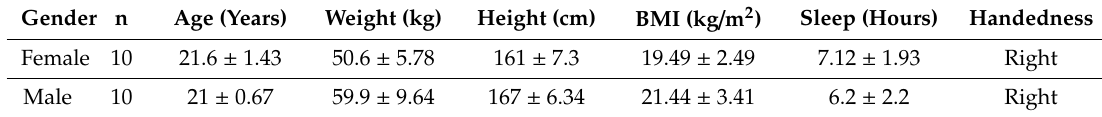
Table 4. Baseline characteristics for brainwave studies. Data are shown as mean ± SD.